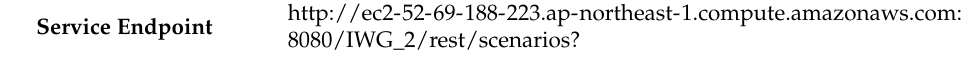
Table 5. Request parameter of the IWG (Intermediate Weather Generator) service.